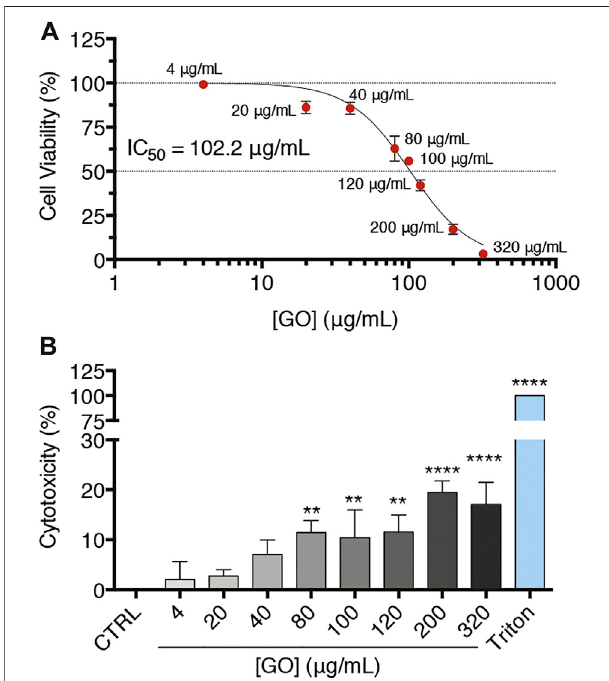
FIGURE 2 | Con fl uent upcyte ® hepatocyte cultures treated with increasing GO concentrations for 24 h. (A) Cell viability of GO-treated cells after 24 h of incubation evaluated by resazurin reduction assay. Results are expressed as percentage values compared to the control conditions (indicated as CTRL). Results represent means ± SD of three independent experiments. The half maximal inhibitory concentration (IC 50 ) of GO was calculatedusingthelog(inhibitor)vs.normalizedresponsecurvesmodel(R 2 = 0.98). (B) Cell membrane damage by cytotoxicity assay in GO-treated cells after 24 h ofincubation. “ Triton ” refers tothe positive control, i.e., cells treated with 0.03% Triton X-100 for 24 h, while “ CTRL ” represents untreated cells. ResultsareexpressedaspercentagevaluescomparedtoTriton(setas100%) after having removed the basal value of CTRL (set as 0%). Results were obtained from three independent experiments (means ±SD). The symbols ‘ ** ’ and “ **** ” refer to p ≤ 0.0038 and p < 0.0001, respectively, calculated versus CTRL (ordinary one-way